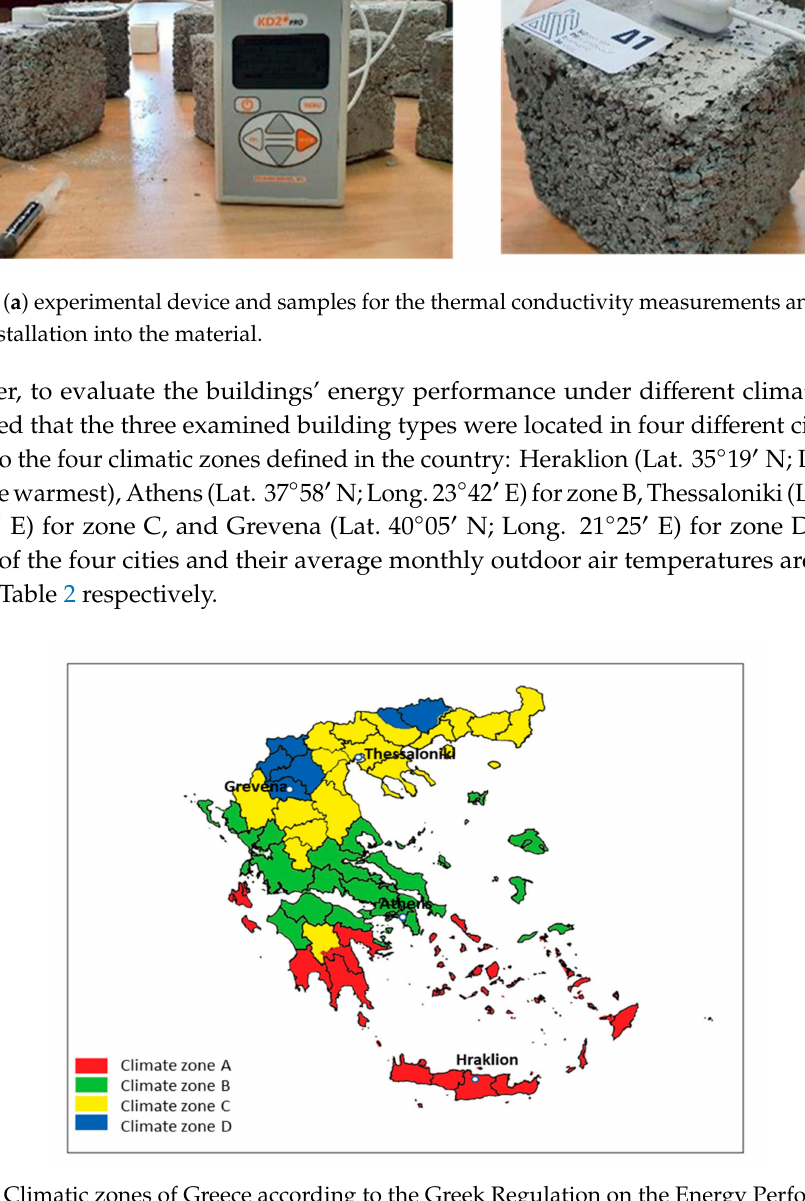
Figure 3. Climatic zones of Greece according to the Greek Regulation on the Energy Performance of Buildings, and locations of the case study cities [41]. Table 2. Monthly average air temperature (Tair) of the 4 investigated cities, corresponding to the 4 climate